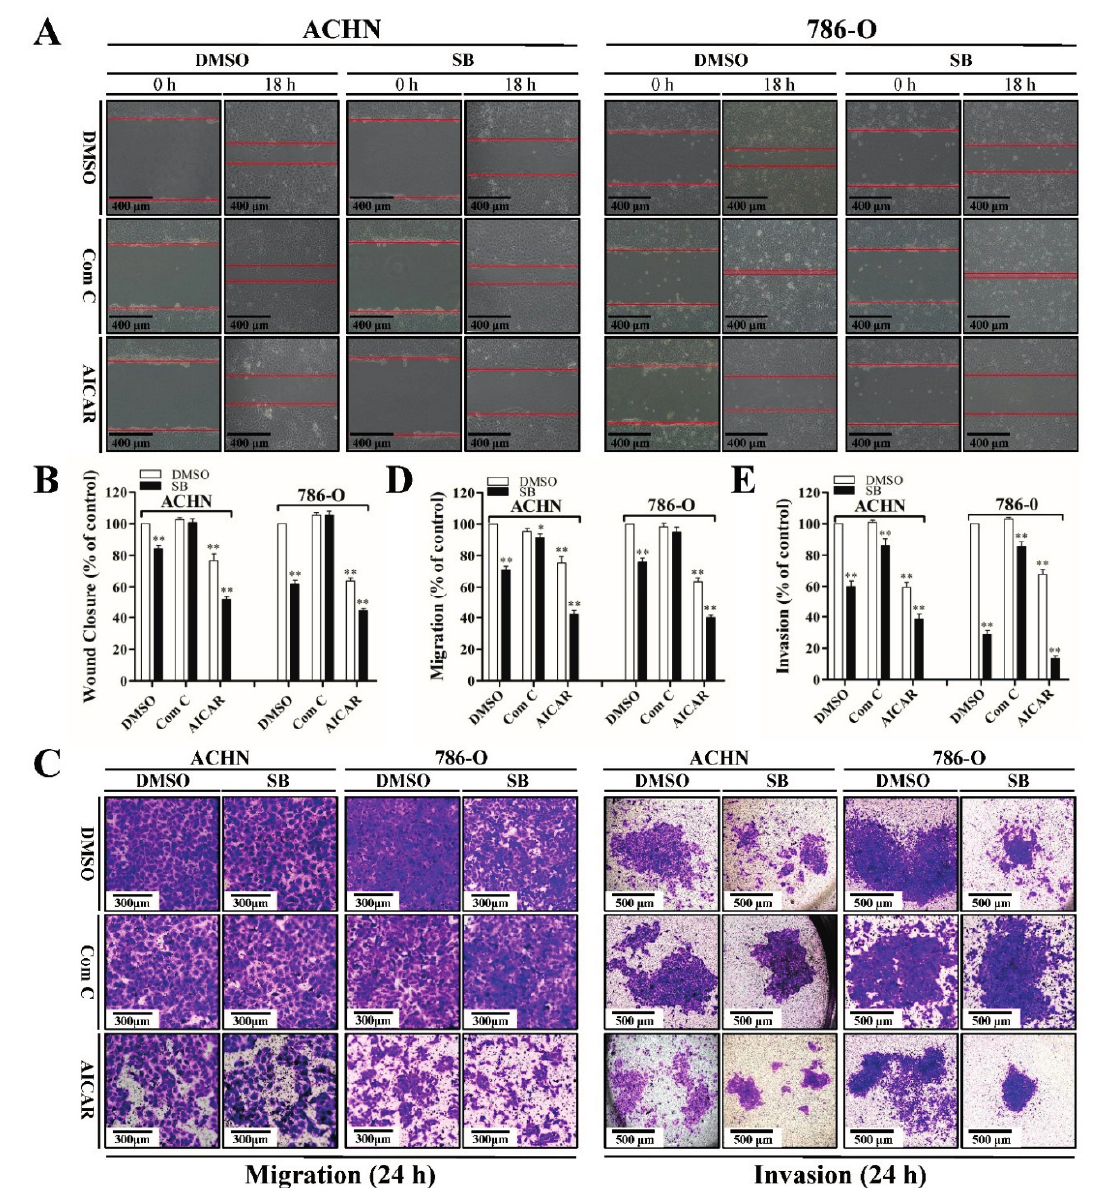
Figure 4. Autophagy induced by silibinin contributes to its anti-metastatic effects. Cells were pre-treated with compound C (Com C, 5 μ M) or AICAR (1 mM) for 4 h and treated with silibinin (SB, 50 μ M) for the indicated time (18 or 24 h). Wound healing assay ( A , B ) and trans-well migration ( C , D ) and invasion ( C , E ) assay were performed. Red lines represent the borders of the wounds. Pictures shown are representative of three separate experiments. Error bars represent SDs. * p < 0.05; ** p <